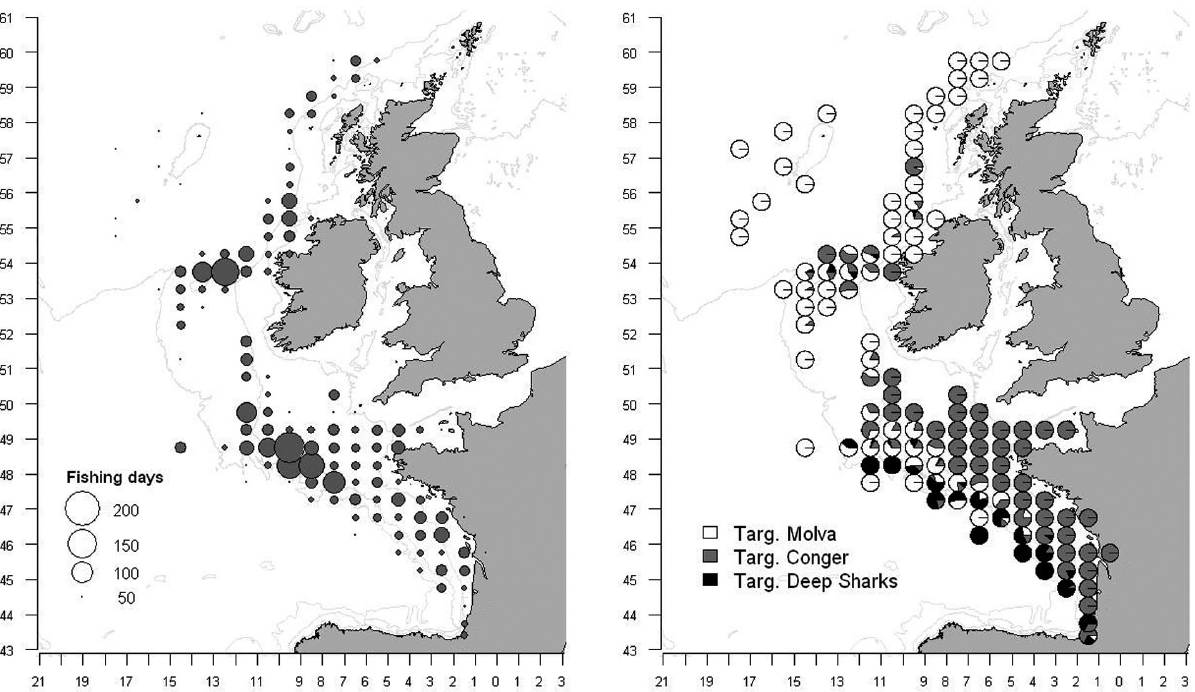
Fig . 5. – Spatial distribution of effort (left) and relative importance by fishing tactic and ICES rectangle of longline in ICES Divisions VI, VII and VIIIabde